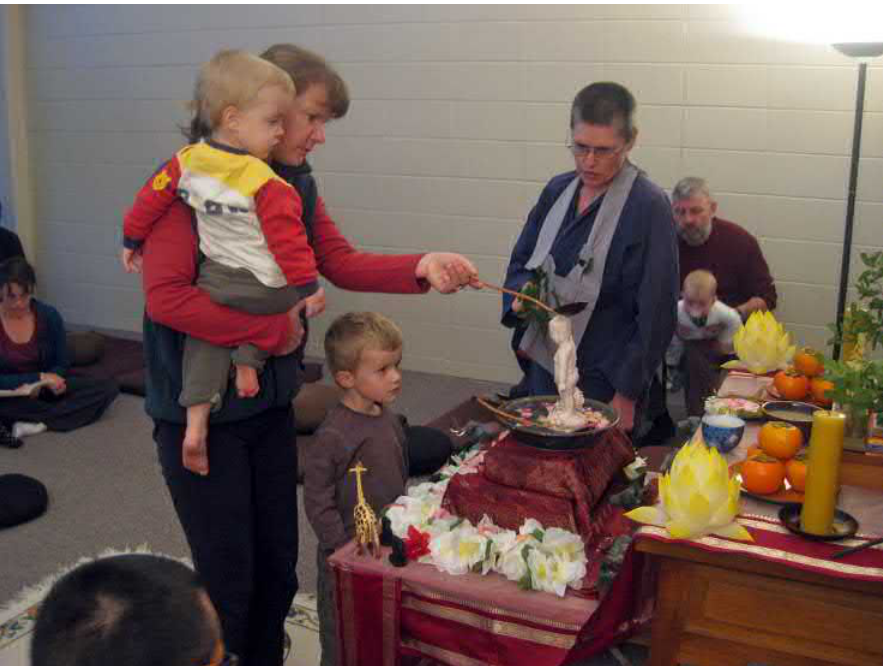
Figure 7: Pākehā/convert Buddhist communities: Zen priest Ven. Amala Wrightson (in robe) with a family participating in the “Bathing the Baby Buddha” celebration of the Buddha’s Birthday (2010). (Photo courtesy of Auckland Zen Centre)